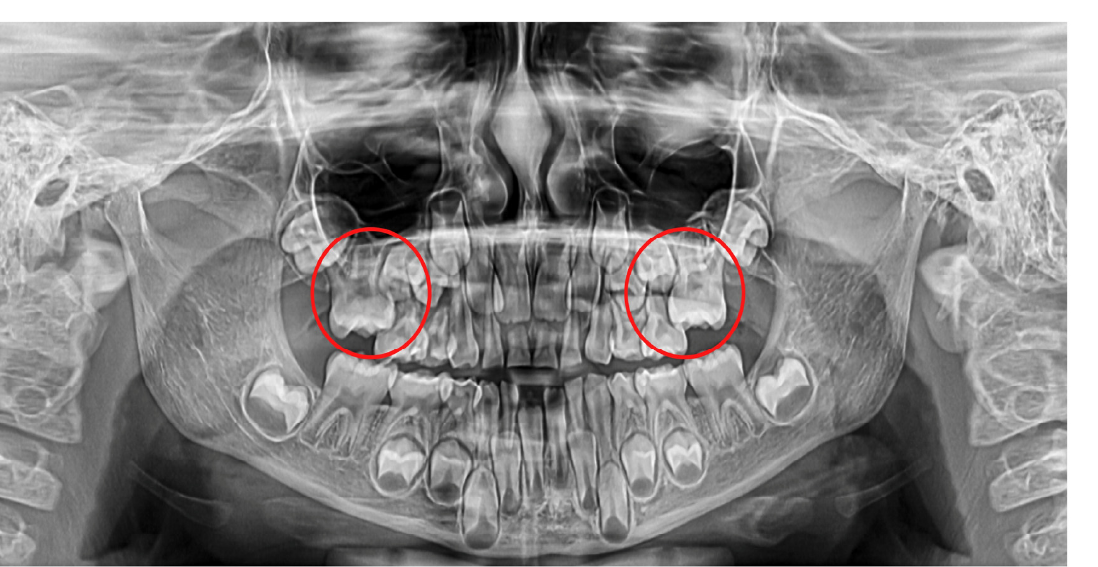
Figure 1. Ectopic eruption of upper first permanent molars.